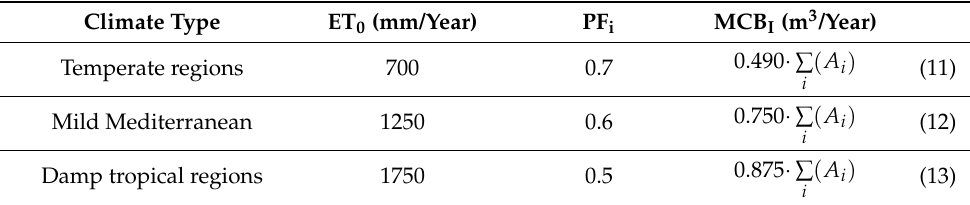
Table 9. Values of MCB I for different climate types and types of